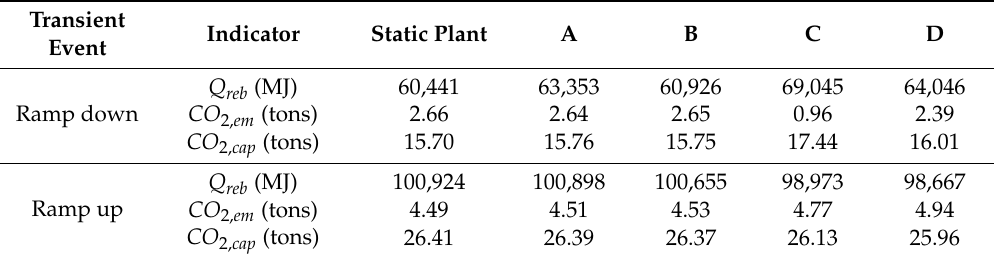
Table 9. Simulation results for accumulated reboiler energy consumption Q reb (MJ), accumulated CO 2 emitted CO 2,em and accumulated CO 2 captured CO 2,cap during the transient event (8 h) for the different control structures A,B, C and D (refer to Table 7), when ramping up and down the plant (between 100% and 70% of flue gas mass flow rate). Static plant refers to an ideal static plant that changes from the initial operating conditions to the final operating conditions instantaneously at time t = 0. An integration time of t f = 480 min was utilized to calculate the values for the ideal static